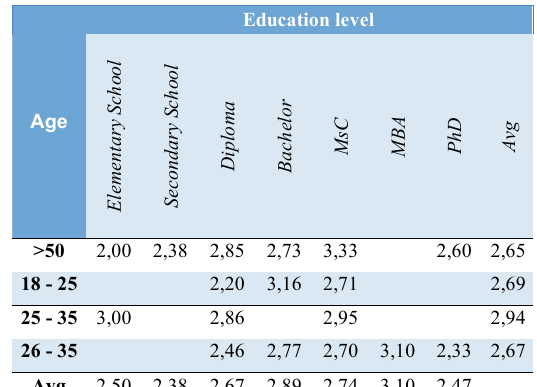
Tab. 1. 2-Factors ANOVA Analysis on average outputs of Q3